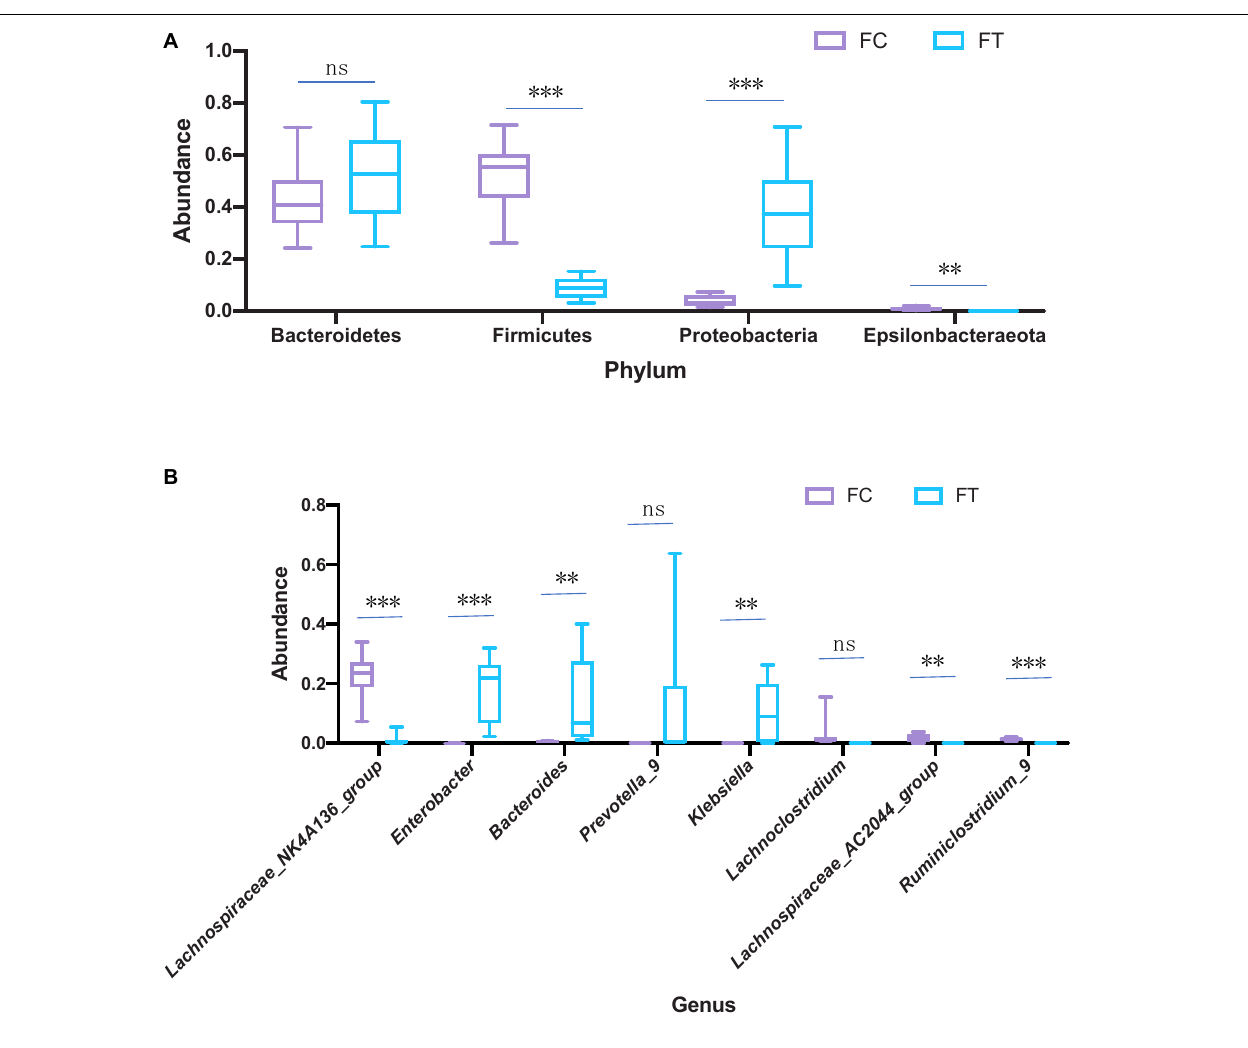
FIGURE 3 | Relative abundance of main phyla (A) and genera (B) that were significantly different in the gut microbiota in the control females (FC) and the antibiotic-treated females (FT). Statistical significance: ∗∗ , P < 0.01; ∗∗∗ , P < 0.001; ns, not significant.